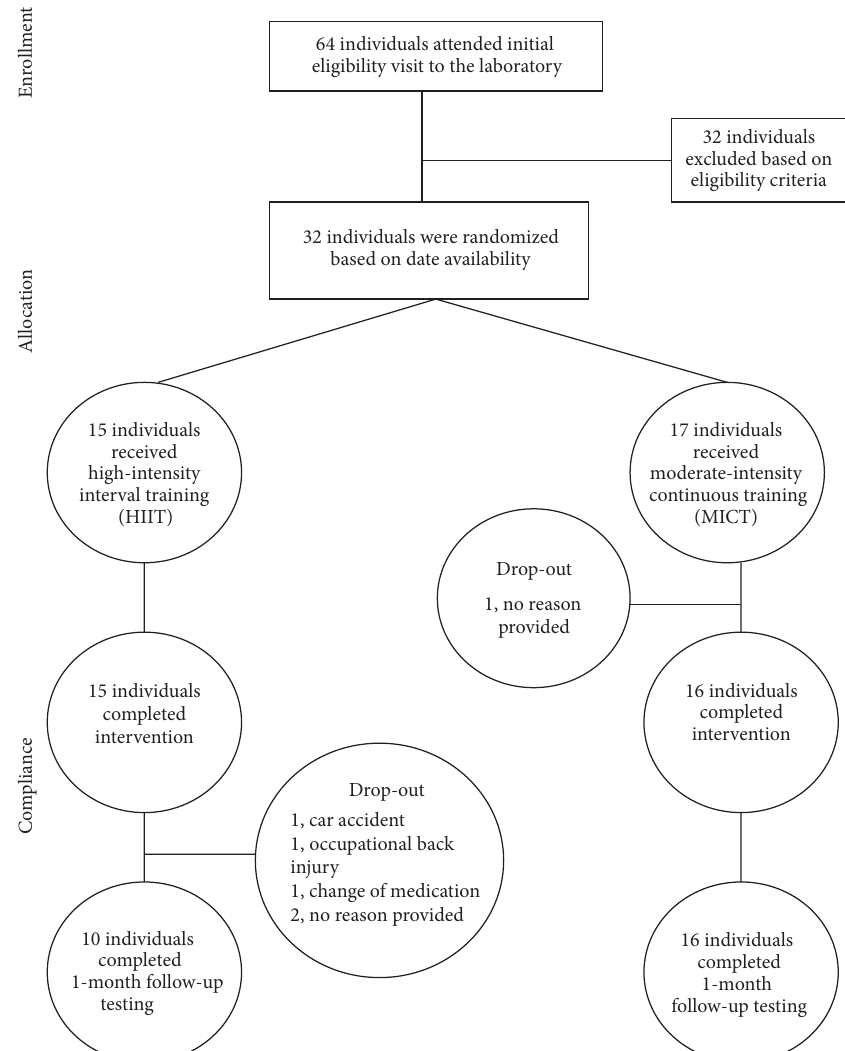
Figure 1: Flow of participants through the